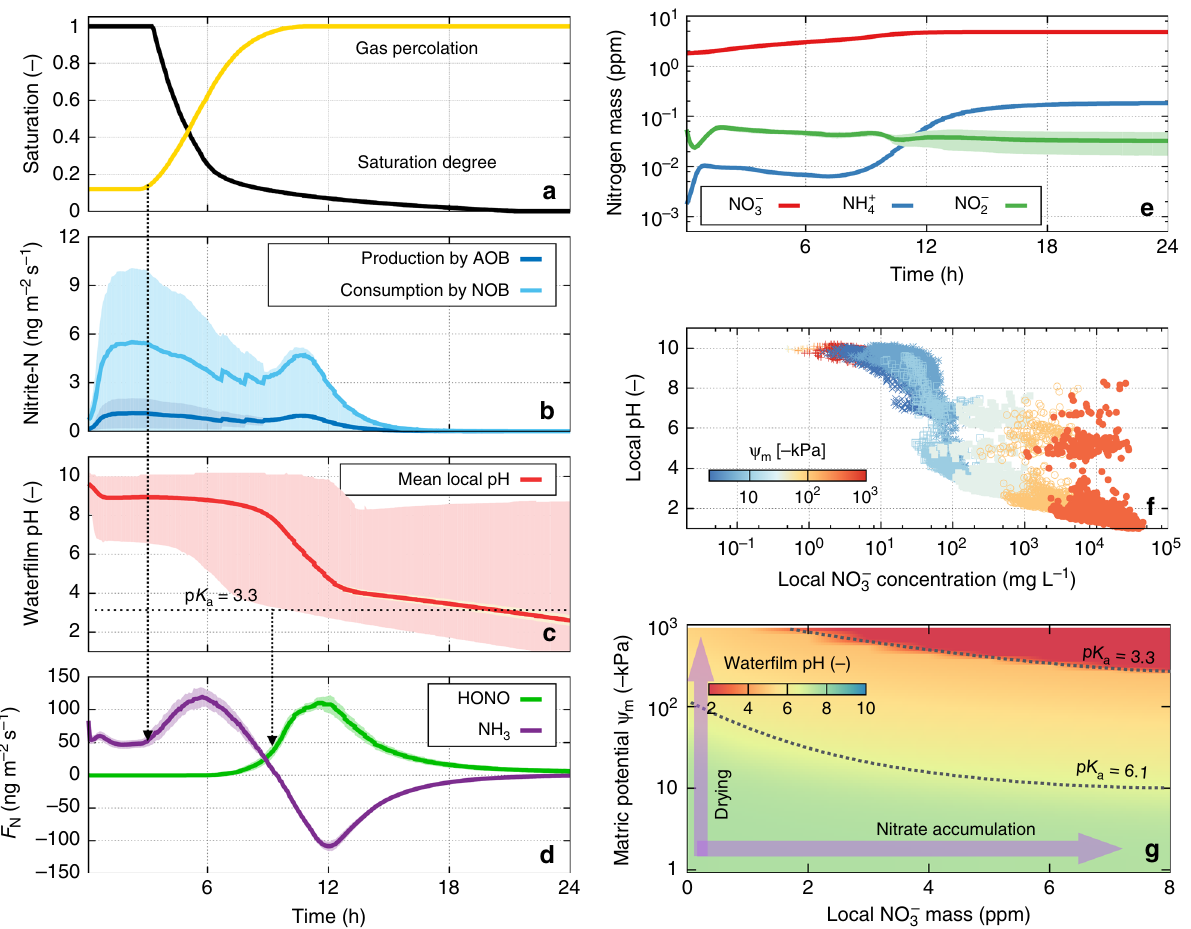
Fig. 5 Predicted dynamic processes during biocrust desiccation. Dynamic processes during biocrust desiccation as predicted by the desert biocrusts model (DBM). The results were obtained from eight different simulations with identical boundary conditions. a Changes in saturation and increase in gas Þ by microorganisms; NO (cid:2) percolation during 24 h drying. b Simulated production and consumption of nirite ð NO (cid:2) consumption by nitrite oxidising 2 2 bacteria (NOB) (light blue) exceeds the production by ammonia oxidising bacteria (AOB) (dark blue). Solid lines are the averaged values and shaded areas indicate 1 standard deviation of all simulations ( n = 8). c Mean local pH (red line) where spatial heterogeneity of local pH spans a wide range of pH values (shaded area indicates from the minimum to the maximum). d The dynamics of nitrous acid (HONO) (green) and ammonia (NH 3 ) (purple) emissions from the model biocrust with positive- and negative- fl ux values indicate emission or uptake by the domain, respectively. e Simulated variations in inorganic Þ (red), ammonium ð NH þ Þ (blue), and NO (cid:2) nitrogen compounds with nitrate ð NO (cid:2) , (green) during drying (values are given in ppm with the unit g g soil − 1 ). 3 2 4 in the aqueous phase plotted against local pH at 4 h intervals ( t = 0, 4, ⋯ , 24) during drying (the colour bar f Simulated local concentrations of NO (cid:2) 3 corresponds to the matric potential, ψ m , and the values are of the simulations). g The relationship between local aqueous fi lm pH as a function of hydration state (expressed as matric potential) and the amount of NO (cid:2) in 3